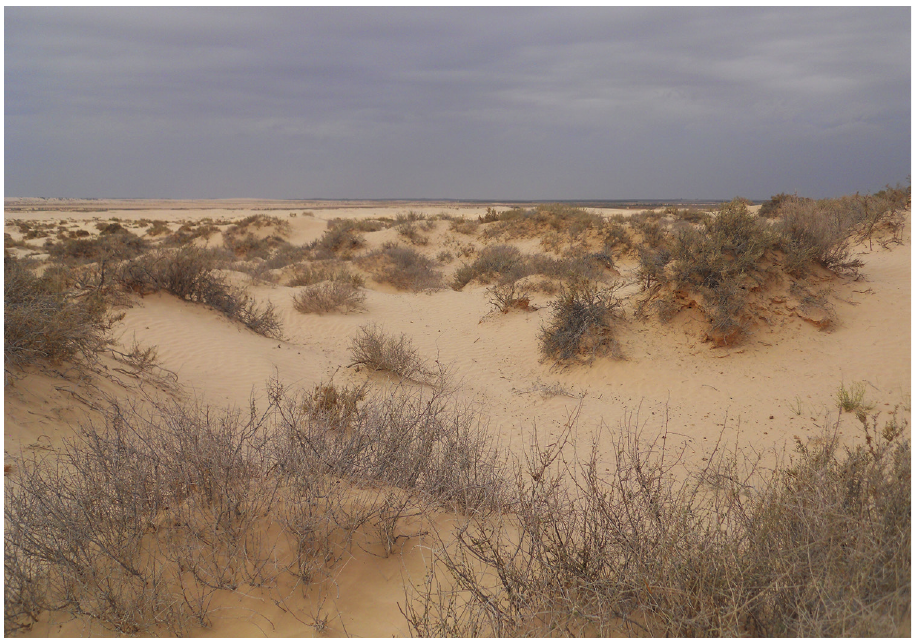
Figure 13. Habitat of Graphipterus piniamitaii sp. n.: Shifting sand dunes with vegetated Nebka hills, Kebili,